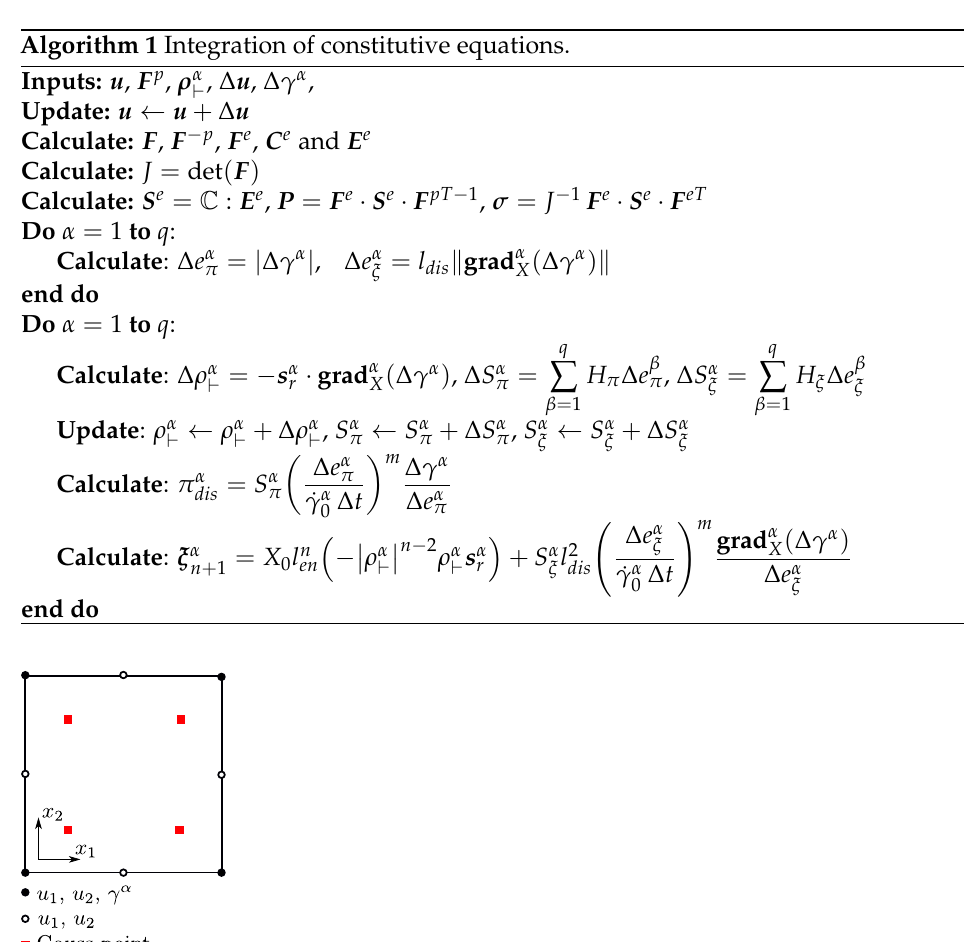
Figure 1. The finite element used in the present